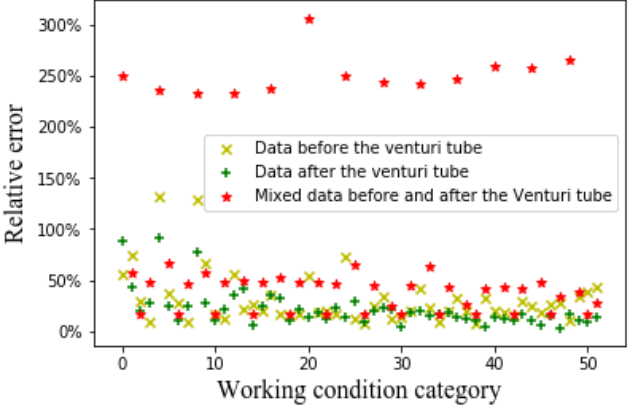
Figure 6. Relative error of oil flow rate with support vector machine (SVM) algorithm.